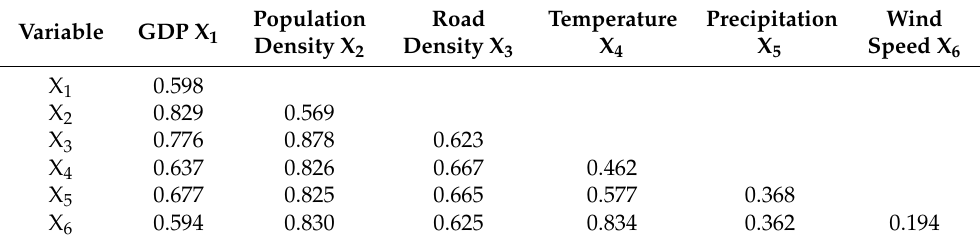
Table 5. Interaction detector results for 2014.